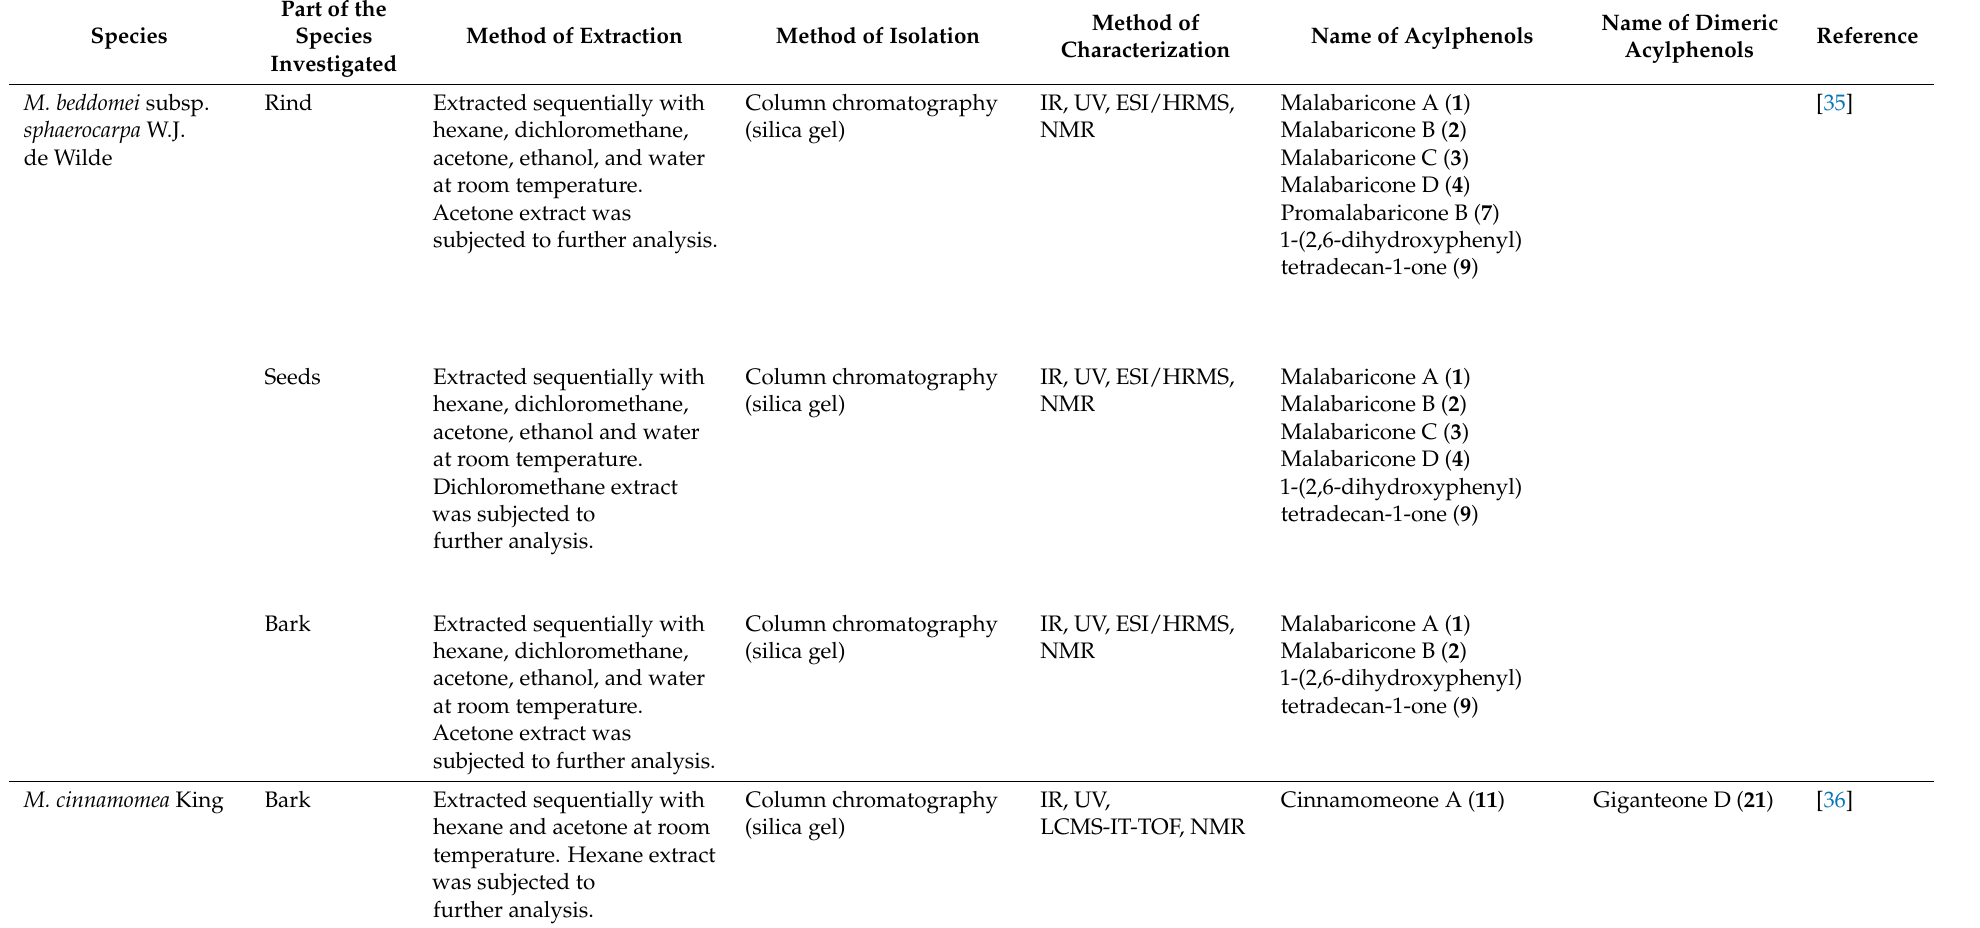
Table 2. Extraction, isolation and characterization of the acylphenols and dimeric acylphenols from the genus Myristica . Part of the Species